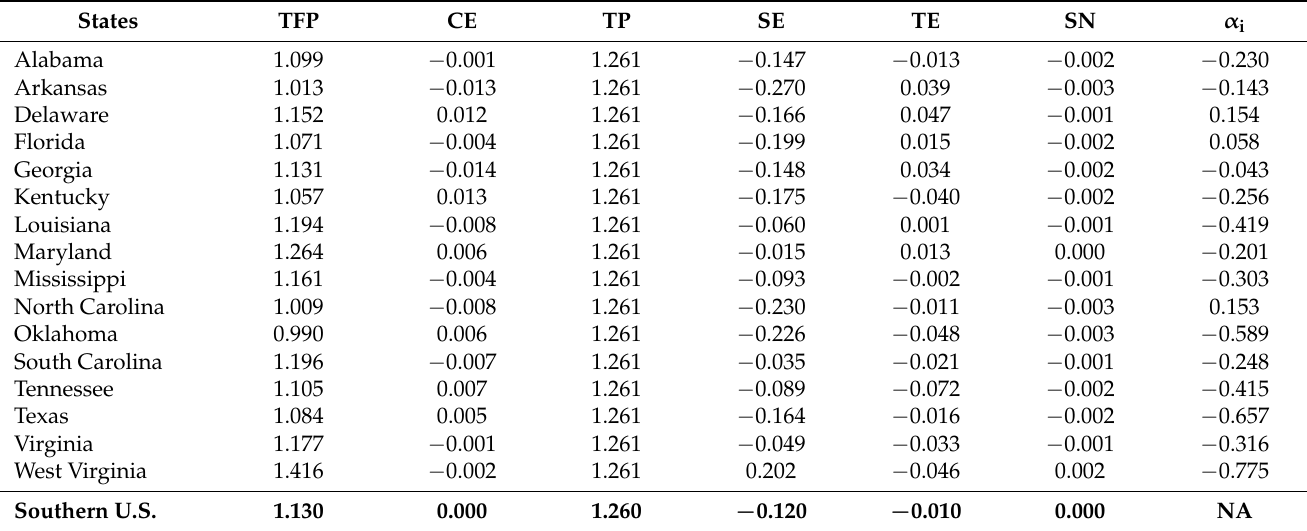
Table 4. Annual average TFP growth rate across southern states, 1960–2004.